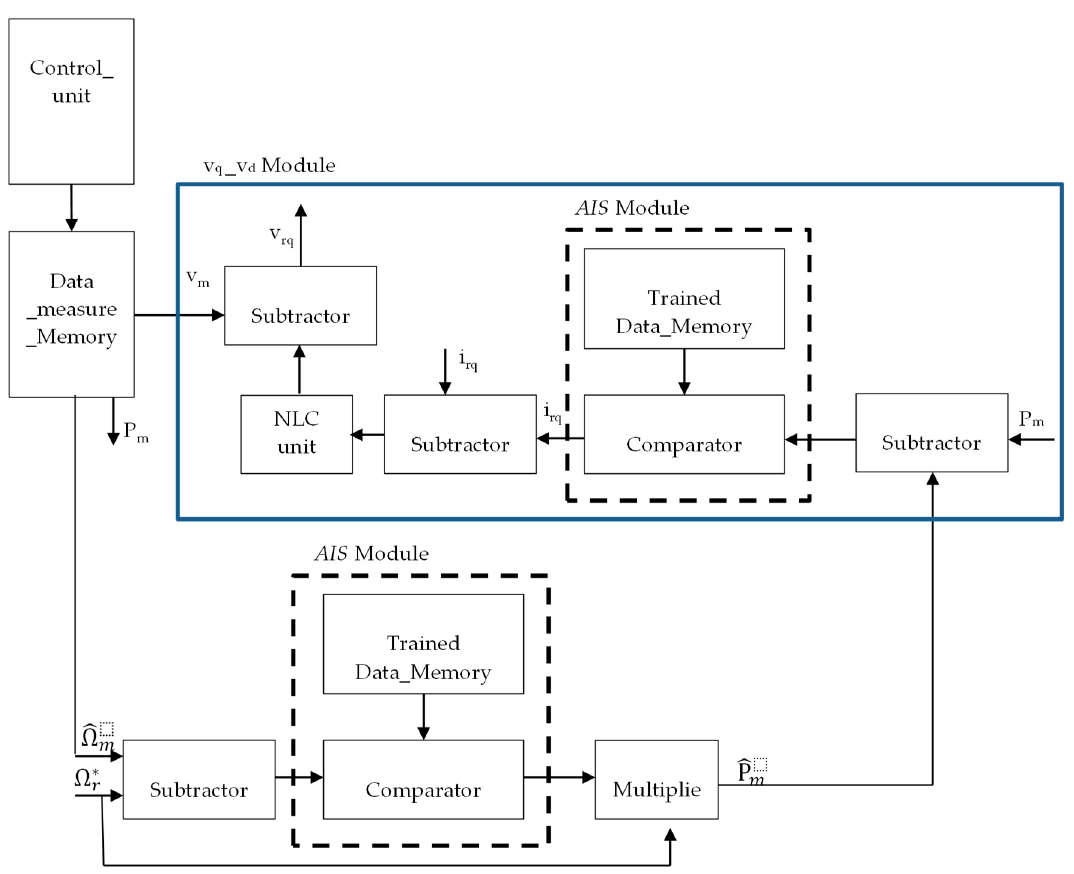
Figure 7. Proposed FPGA hardware implementation of proposed controller system.